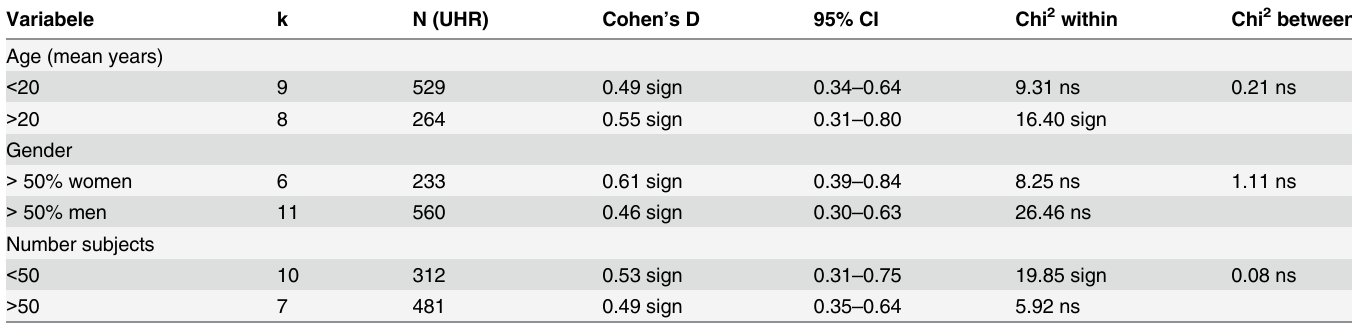
Table 2. Moderator